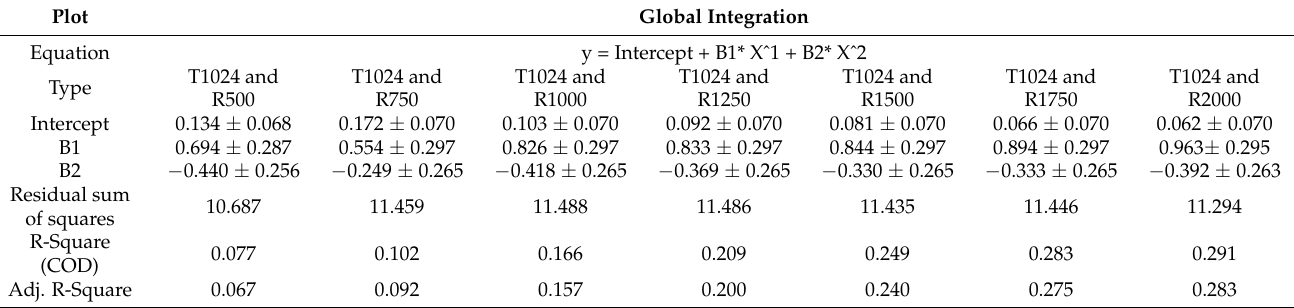
Table 8. Global integration and through angle and limit distance range polynomial curve fitting analysis.